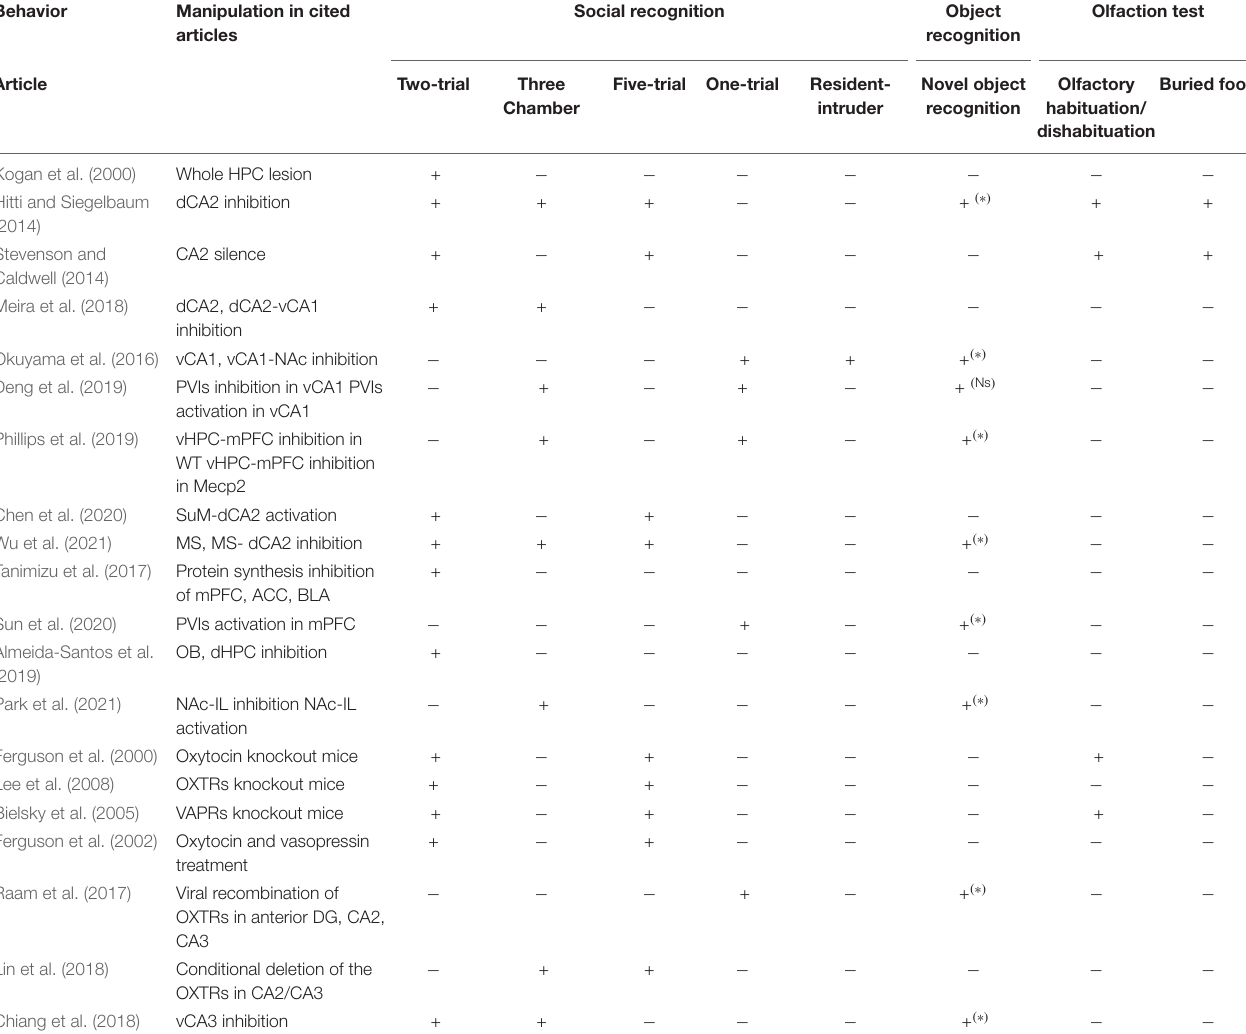
TABLE 1 | Behavioral outcomes after manipulation of neural circuits using different social and non-social behavioral paradigms.